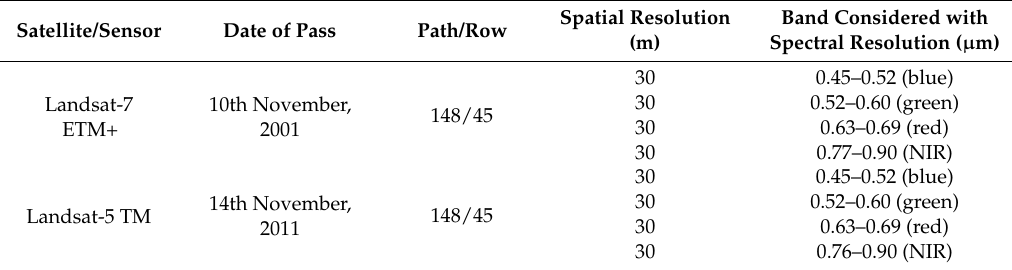
Table 1. Details of the satellite data used for land use map